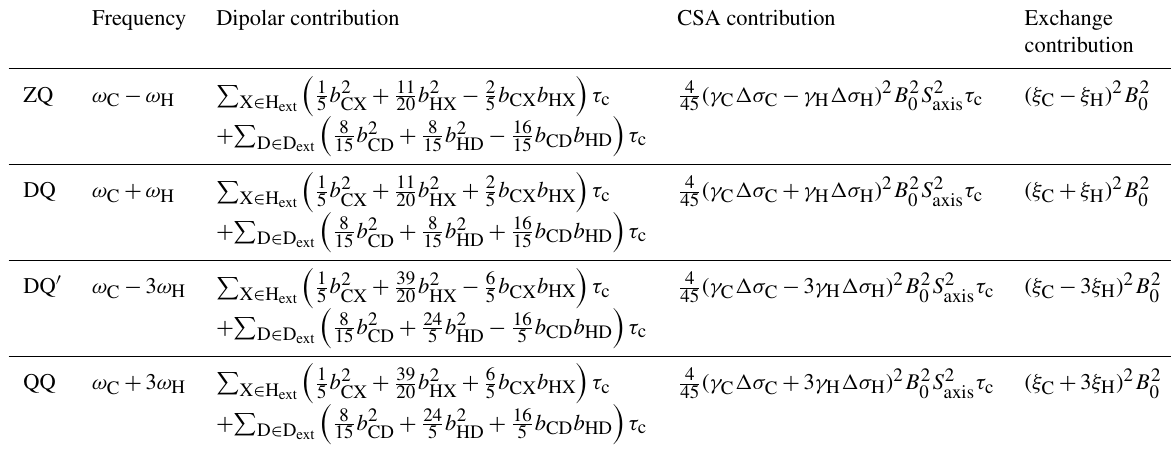
Table 1. Theoretical transverse relaxation rates of selected multiple quantum methyl transitions. Expressions for relaxation rates are divided into dipolar, CSA and exchange contributions, and transitions are labelled as indicated in Fig. 1. Dipolar contributions are summed over external protons and deuterons, H ext and D ext , where b AB is the dipolar coupling between a methyl spin A and an external proton or (cid:125) γ A γ B P 2 (cos θ B ), and P 2 ( x ) = 1 deuteron B, b AB = µ 0 (3 x 2 − 1). Exchange contributions are calculated in the fast exchange limit, where 2 4 πr 3 AB the normalised chemical shift differences ξ are defined in Eq.